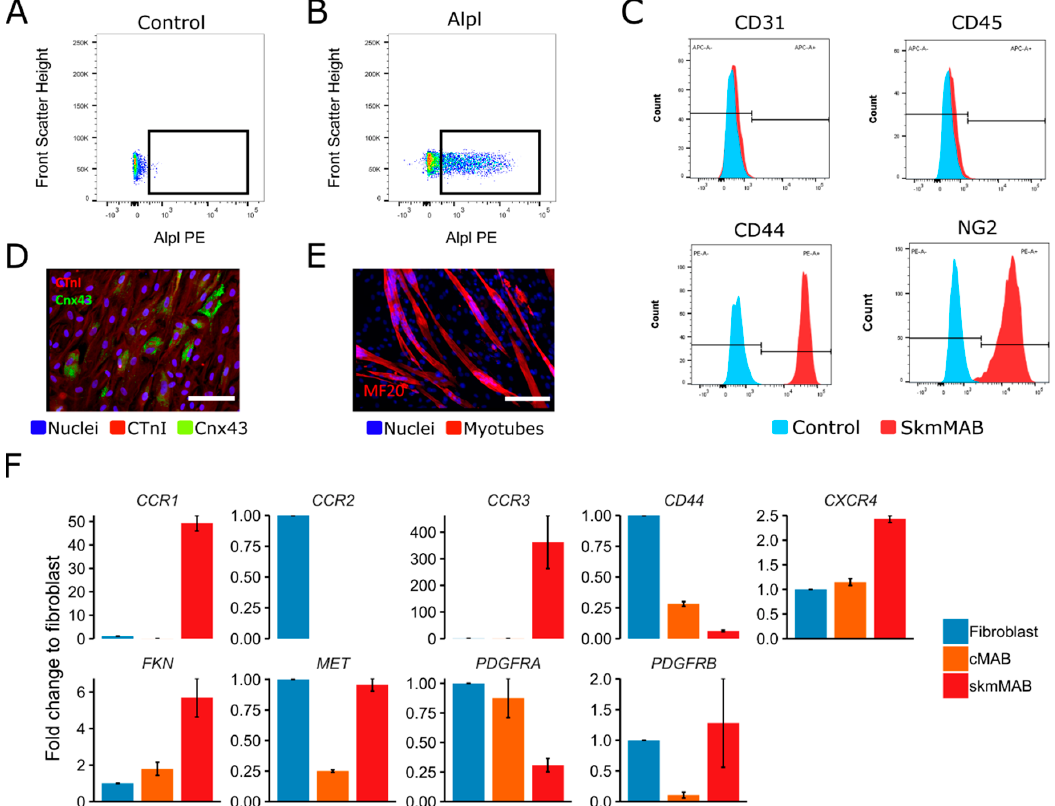
Figure 7. Isolation, characterization and chemokine receptor screening in human interstitial stem cells. ( A , B ) Gating strategy for FACS isolation of human MAB ( A ) and control ( B ). ( C ) Flow cytometry analysis of characteristic receptors. ( D ) Microscopy images of cardiac differentiation of cMAB; cardiomyocytes are stained with CTnI (red) and Cnx43 (green), nuclei are stained with Hoechst (blue). ( E ) Microscopy images of myogenic differentiation of skmMAB; myotubes are stained with MyHC (red), nuclei are stained with Hoechst (blue). ( F ) qPCR analysis of chemokine receptor genes; values shown as fold change expression ± S.E.M. compared to fibroblasts, normalized to RPL13A . n = 2–3. In ( D , E ), scale bar, 50 µm.